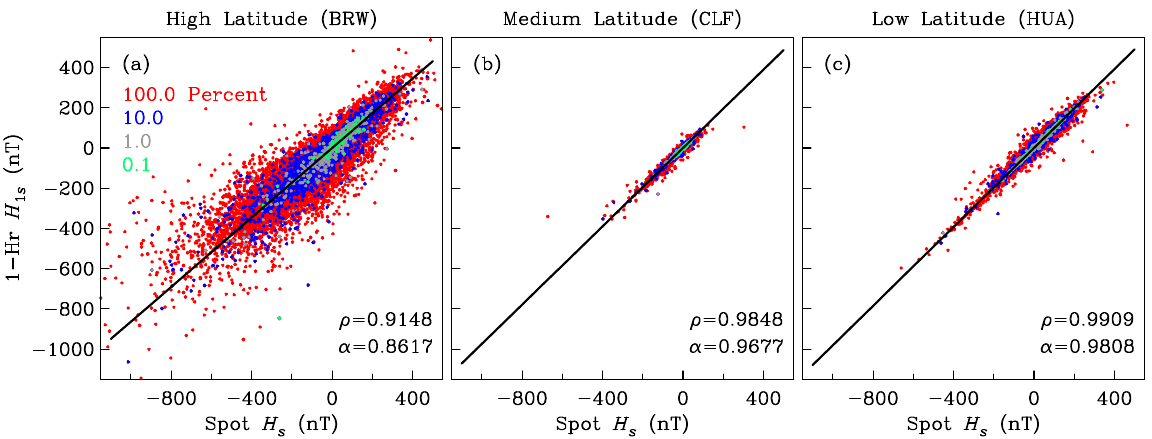
Fig. 7. Scatter plots of discrete 1-h average-samples H 1s (t j ) versus spot samples H s (t j ) for (a) high latitude (BRW), (b) medium latitude (CLF), and (c) low latitude (HUA). Also given, for each case, are correlation coefficients ρ and proportionalities α (shown as a fitted line). Data used are for 1998.0-2009.0, and densities are for 100.0, 10.0, 1.0, and 0.1% of the data. Table 5. Correlations with brick-wall average samples and proportionalities with spot samples, 1998.0-2009.0.